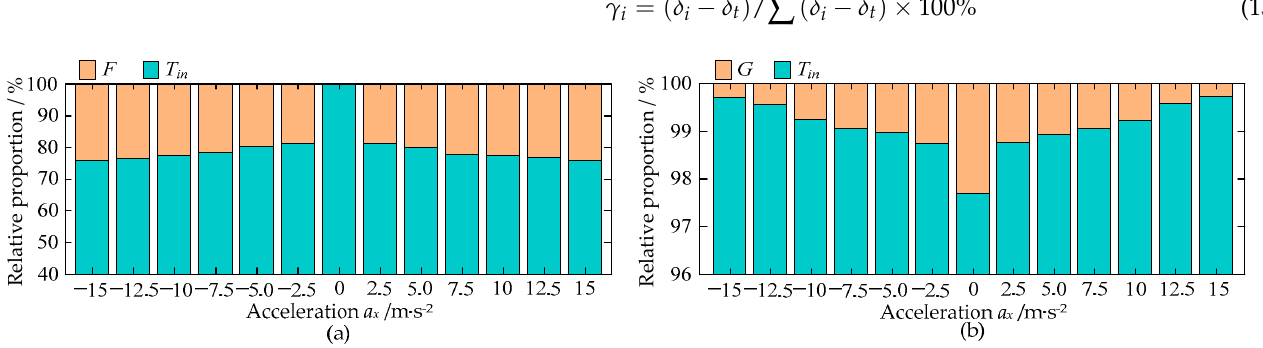
Figure 13. Relative proportion of each influence factor: ( a ) displacement response in x -direction; ( b ) displacement response in y -direction.